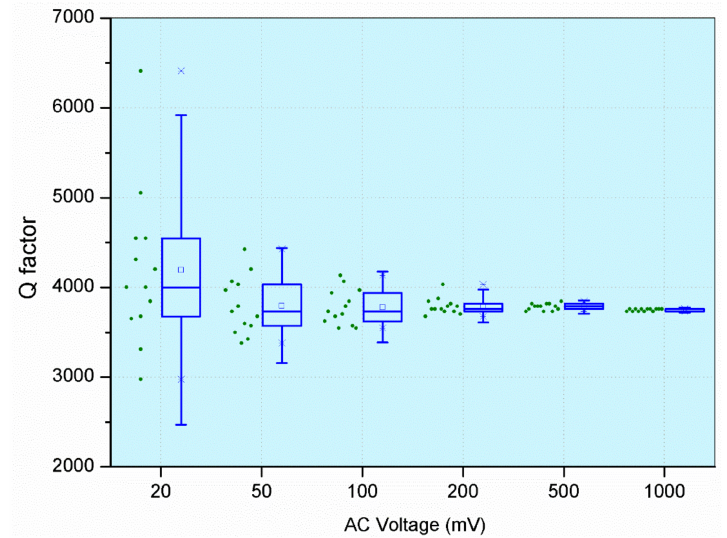
Figure 4. Measurement variations in the Q factor from increasing the AC